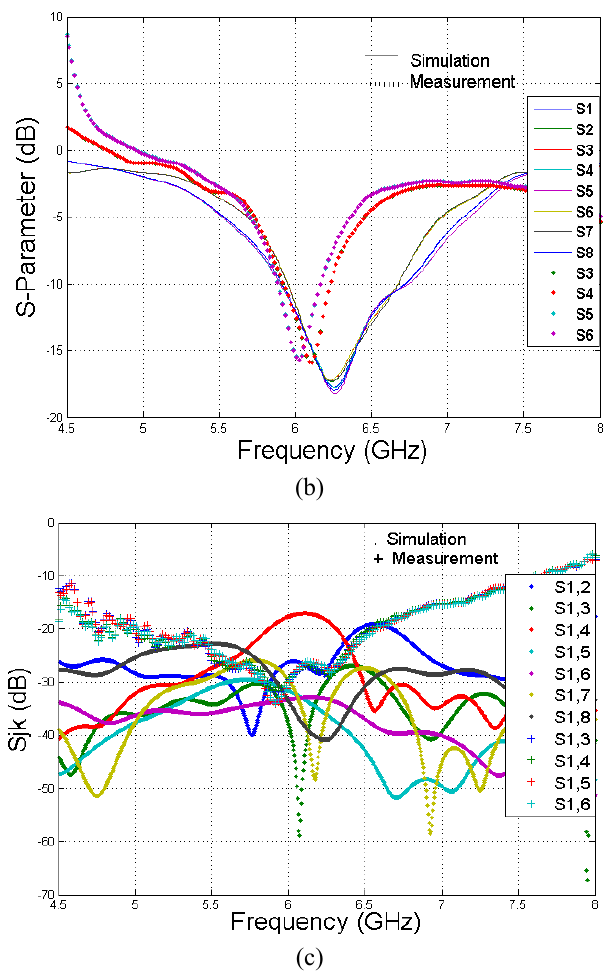
FIGURE 5: MIMO antenna system results (a) measurement screen, (b) S nm and (b) S jk